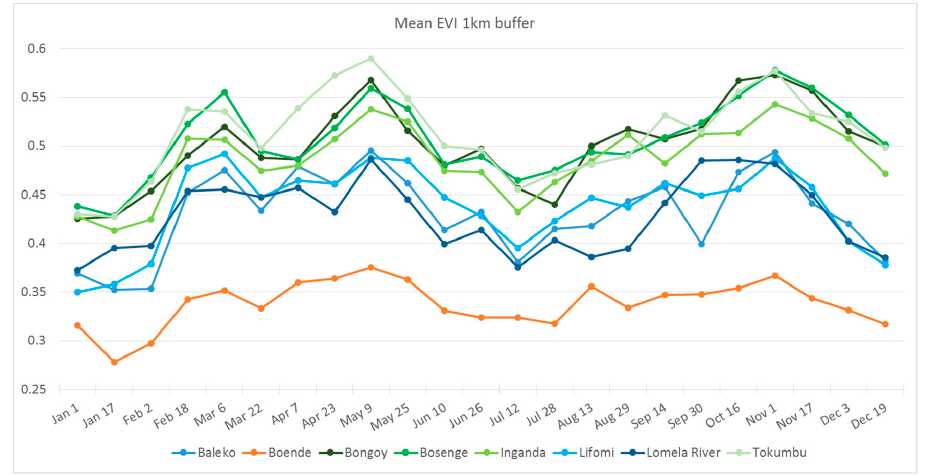
Figure 4. Time series of five-year average enhanced vegetation index (EVI) values within a 1 km buffer from each of the collection localities. Bongoy, Bosenge, Inganda, and Tokumbo showed higher EVI values throughout the year than the rest of the localities.